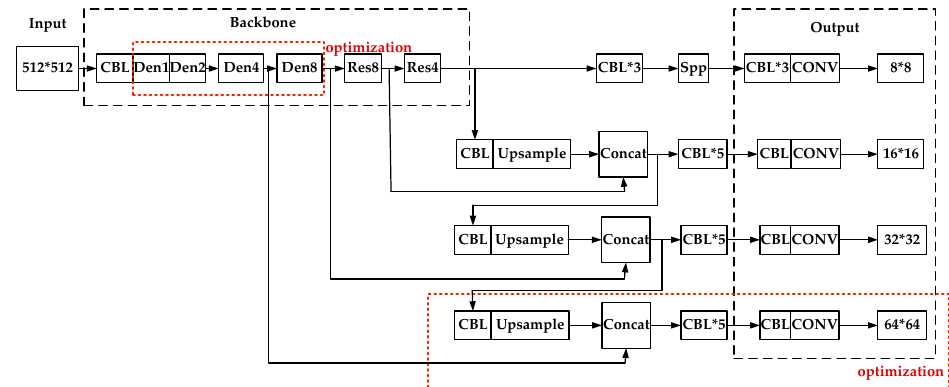
Figure 2. DSSP-YOLO Network Architecture.